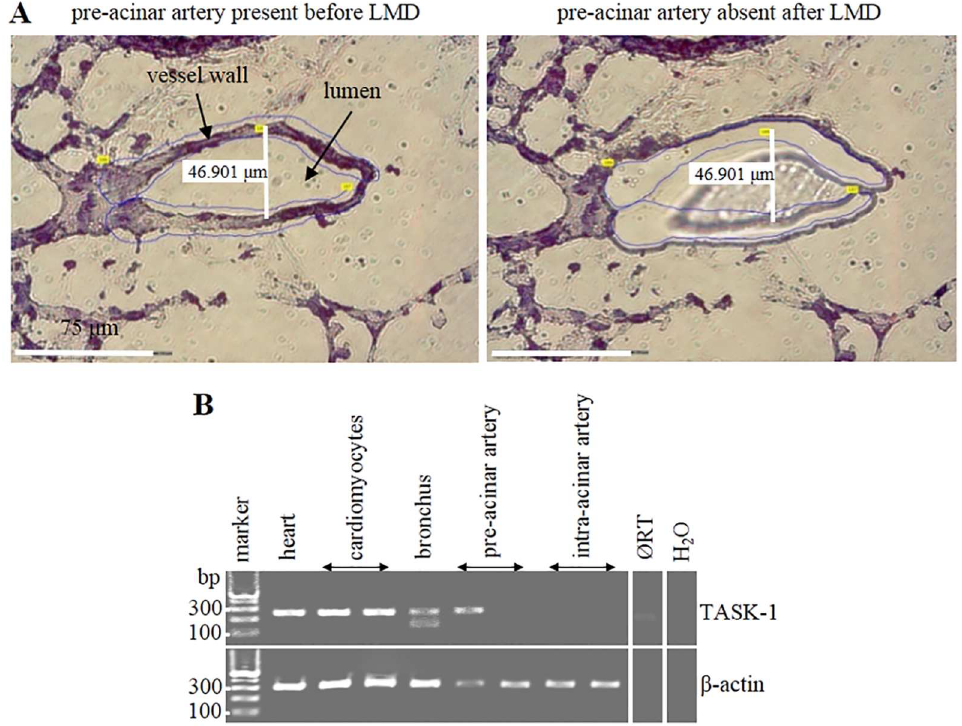
Fig 2. Laser-assisted Microdissection (LMD) and expressionof TASK-1 in WT murine intra-pulmonary arteries. (A) LMD. The white line indicatesthe luminaldiameterof a pre-acinarartery. It represents the maximum distancebetweenintimal surfaces at right angle (90˚) to the longitudinal axis. The area of vessel to be picked was first marked (blue lines; left panel). The marked piece of tissue (missing in right panel)was catapultedinto the lid of a reactiontube and processedfor RT-PCR. (B) RT-PCR of laser-assisted microdissected samples, agarosegel. Ø RT is sample of cardiomyocytes processedwithout Reverse Transcriptase (RT). β -Actin was used as internalcontrol. Heart served as positive control. H 2 O is control without cDNA template.